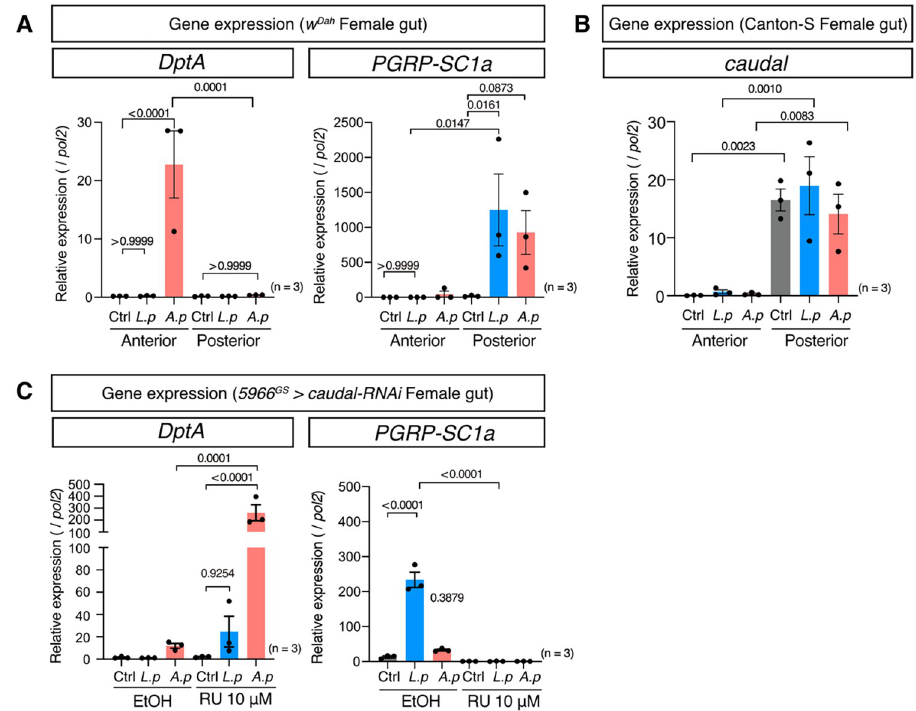
Fig 4. Differential expression of Imd target genes in the anterior and posterior midgut. (A) Quantitative RT–PCR of DptA and PGRP-SC1a (A) in female w Dah anterior and posterior gut after 24 hours of BacD. For the statistics, ANOVA with Holm-Sˇı´da´k’s multiple comparison was used. (B) Quantitative RT–PCR of caudal in female Canton-S anterior and posterior gut after 24 hours of BacD. For the statistics, ANOVA with Holm-Sˇı´da´k’s multiple comparison was used. (C) Quantitative RT–PCR of DptA and PGRP-SC1a in the gut of female 5966 GS > caudal-RNAi flies after 24 hours of BacD. For the statistics, ANOVA with Holm-Sˇı´da´k’s multiple comparison was used. The control diet followed the same procedure for BacD but it has only MRS broth in place of bacterial isolates, resulted in the antibiotics- contained diet. Sample sizes (n) and P values are in each figure.